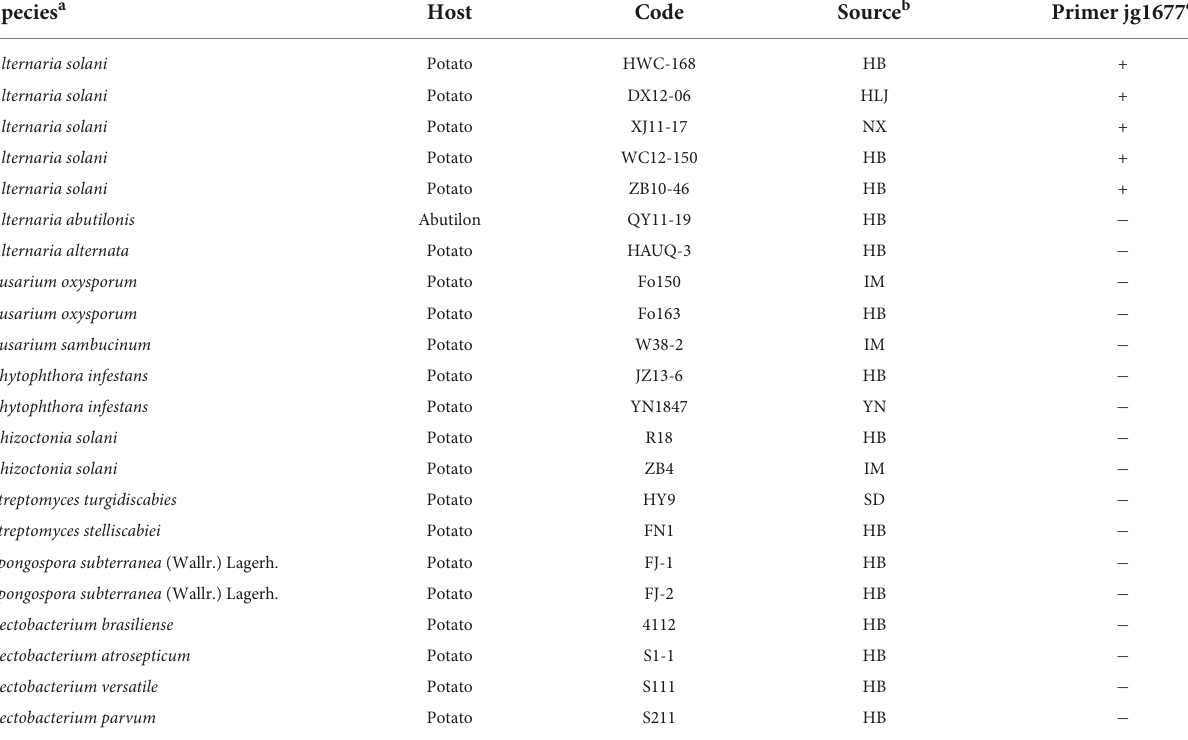
TABLE 2 Microbial isolates used in this study.